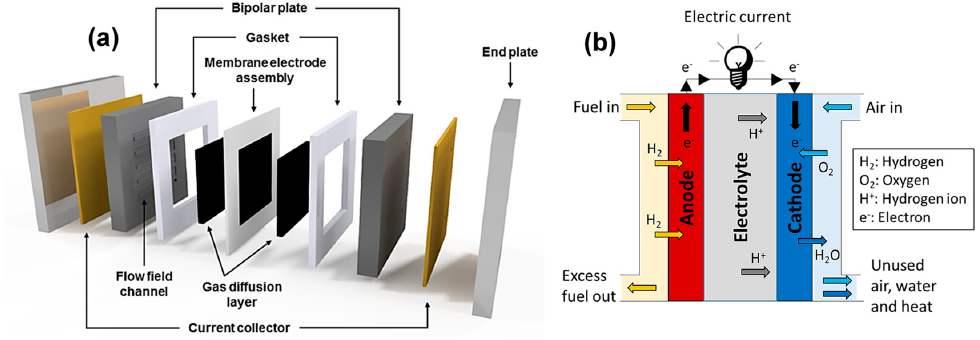
Figure 1. ( a ) Main components of a polymer electrolyte membrane fuel cell (PEMFC) and ( b ) schematic of a typical membrane electrode assembly (MEA).